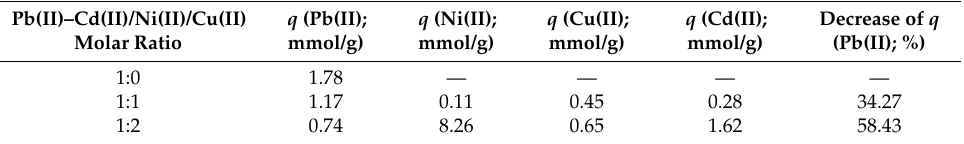
Table 4. Adsorption capacities (q) in multi-elemental solutions.